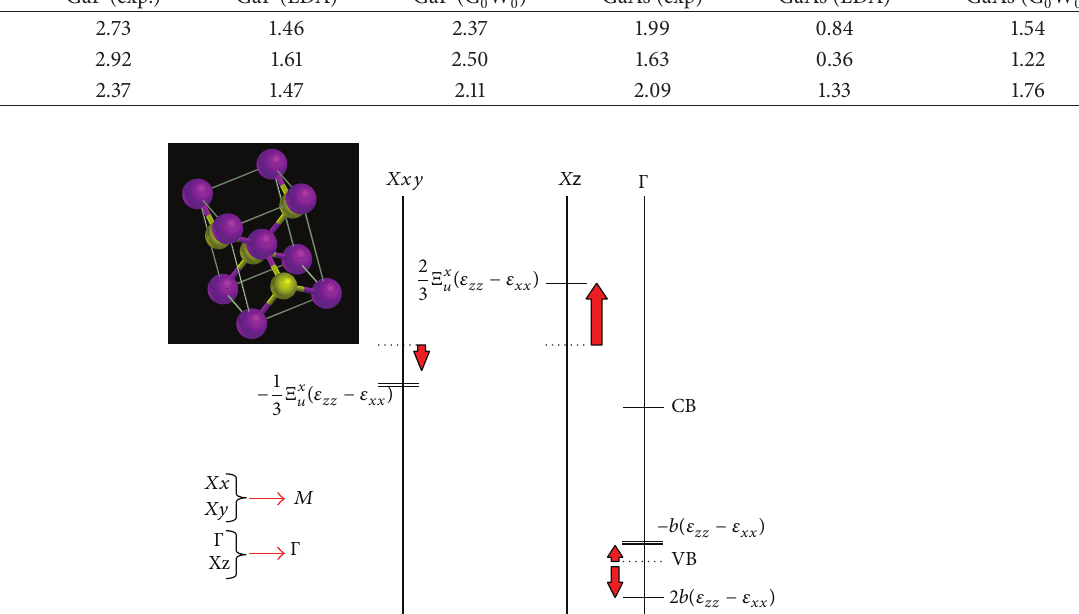
Table 1: Electronic band-gap energies at 𝑇 = 0 K without SOC derived from experiment [55] and calculated at the LDA and LDA + G levels.